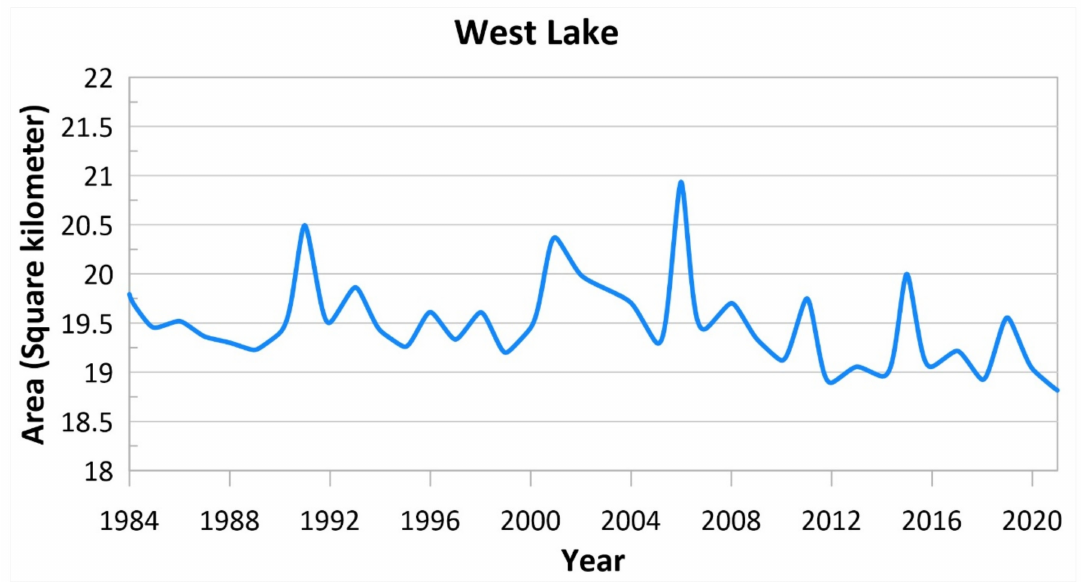
Figure 7. Spatiotemporal monitoring of West Lake from 1984 to 2021.